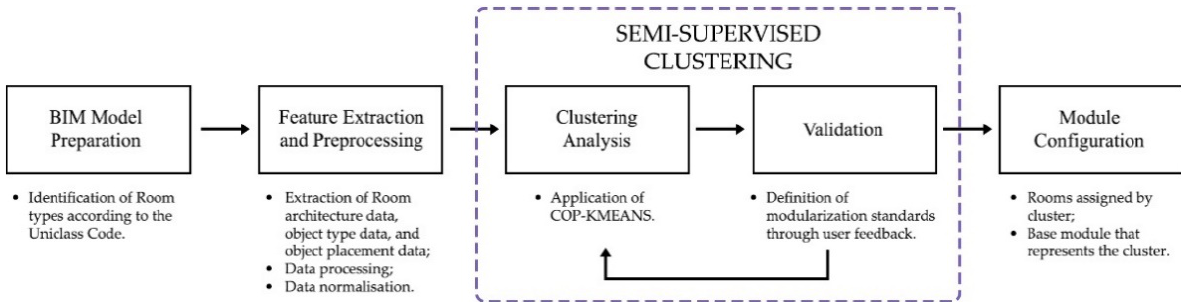
Figure 1. Semi-supervised clustering methodology for room modularisation.